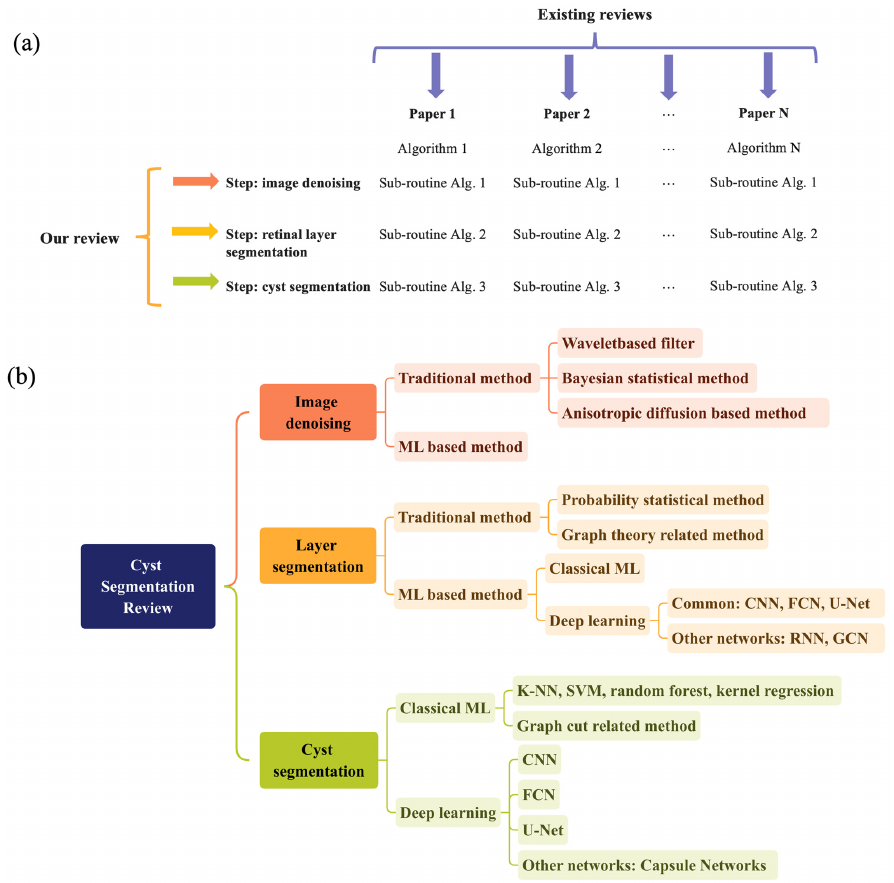
Figure 2. The perceptive and the structure of our review: ( a ) the perspective of our review on the cyst segmentation problem compared with the existing reviews; ( b ) the structure of our review on the cyst segmentation problem.